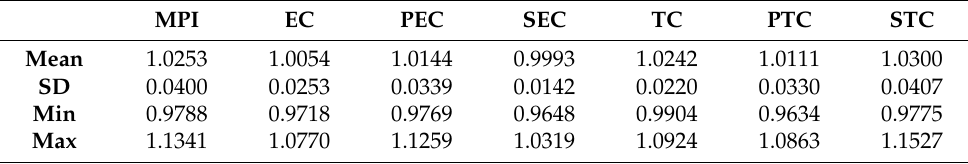
Table 4. Descriptive statistics of the productivity index and its components